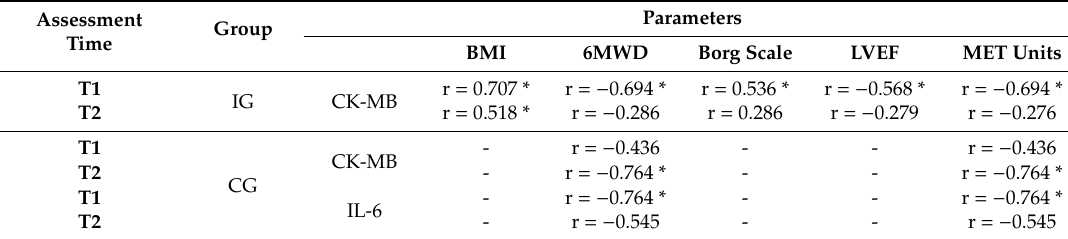
Table 5. Correlation between the blood parameters and BMI, physical capacity, and heart function